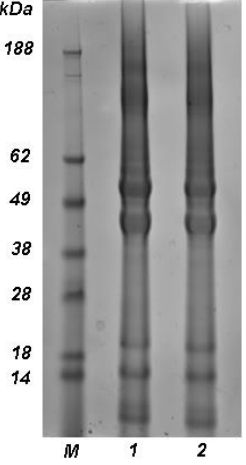
Figure 1. Electrophoresis pattern of marker ( line M ), pristine keratin ( line 1 ) and keratin regenerated from HFIP ( line 2 ). The electrophoresis was carried out using a 4–20% gradient gel, by loading each well with 20 μL of sample solution (10 μg/μL).